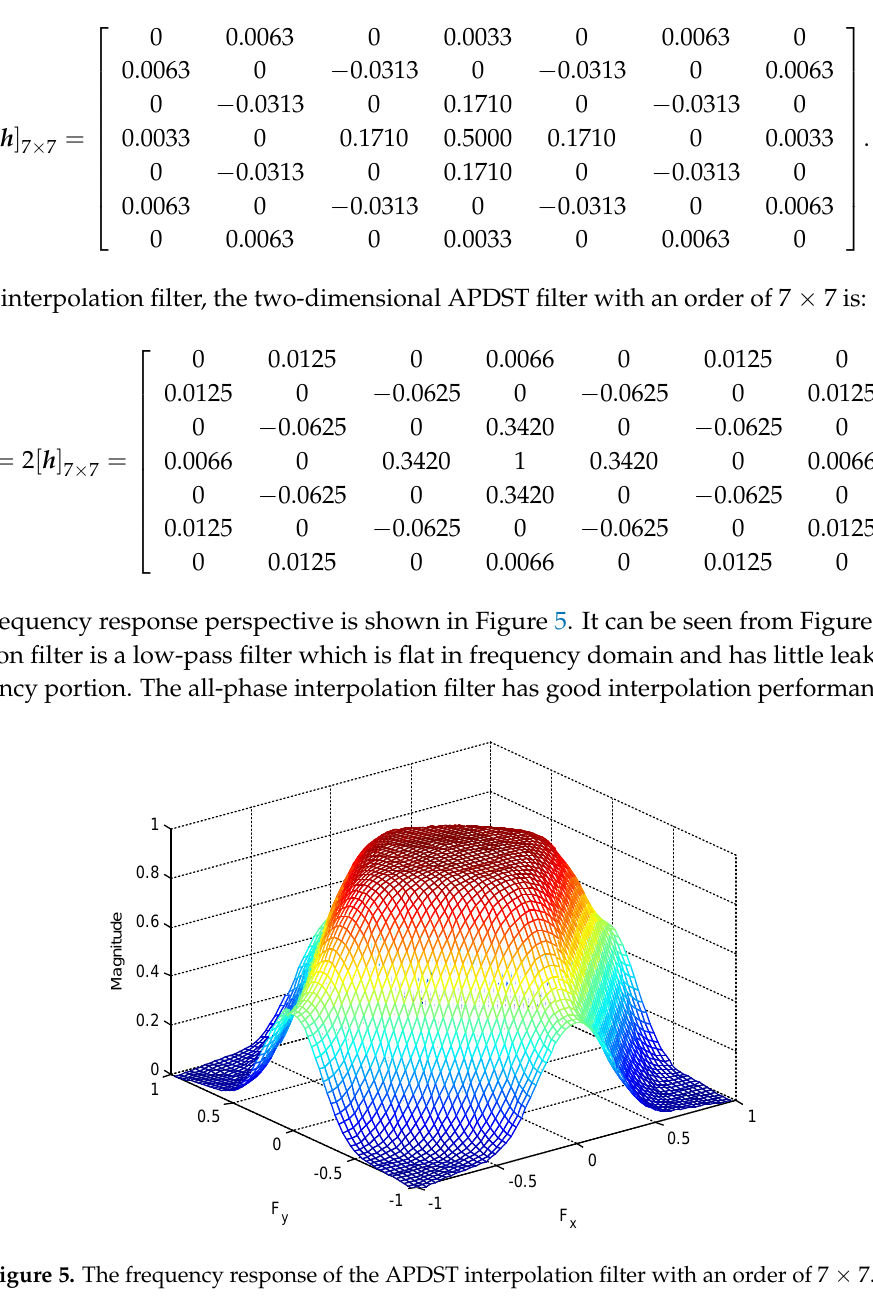
Figure 5. The frequency response of the APDST interpolation filter with an order of 7 × 7.